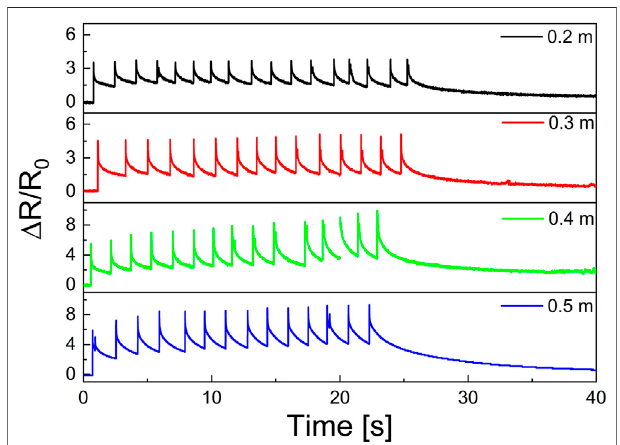
FIGURE 10 | The electrical resistance response to cyclic drop weight test with the drop heights of 0.2, 0.3, 0.4, and 0.5 m.